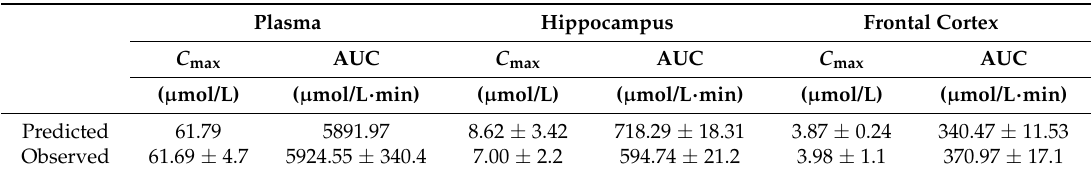
Table 3. Summary of predicted and observed pharmacokinetic parameters of phenytoin in plasma, hippocampus and frontal cortex in